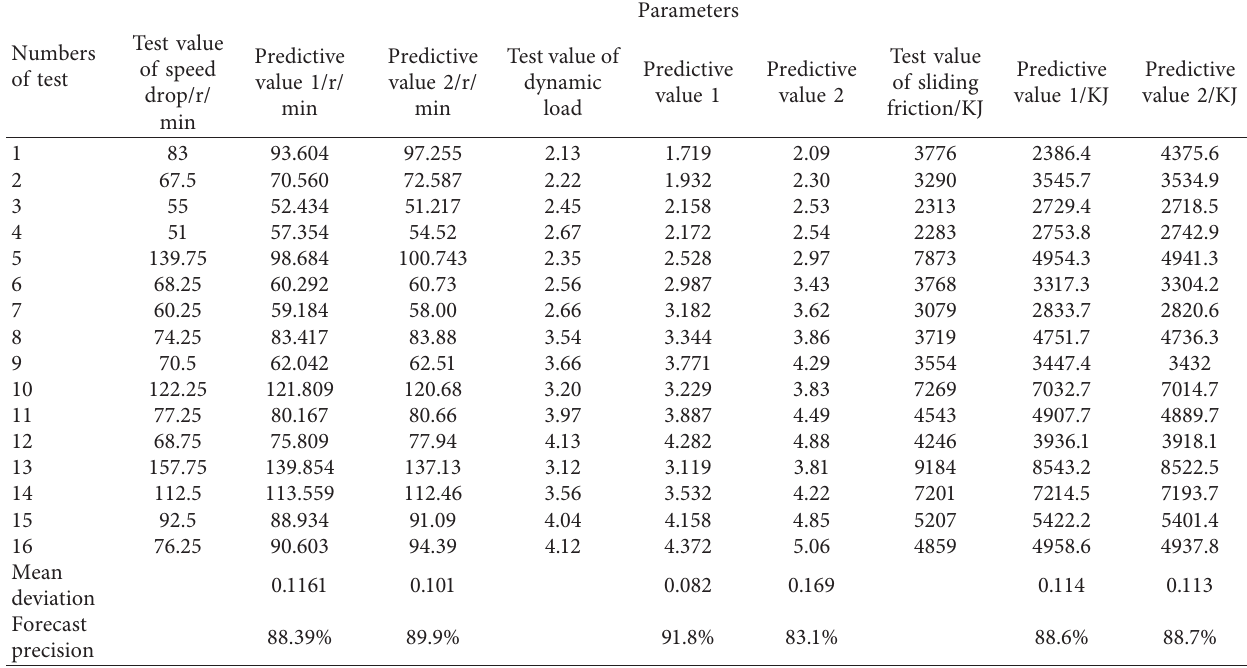
Table 10: Comparison of predication accuracy between two models.